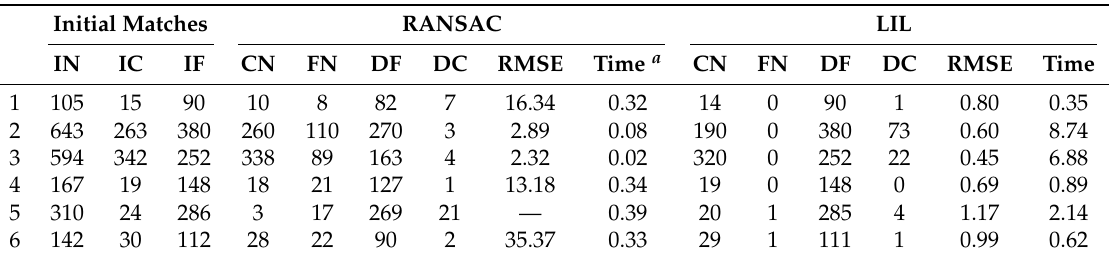
Table 6. Experimental results of RANSAC and LIL outlier removal on real remote sensing images.